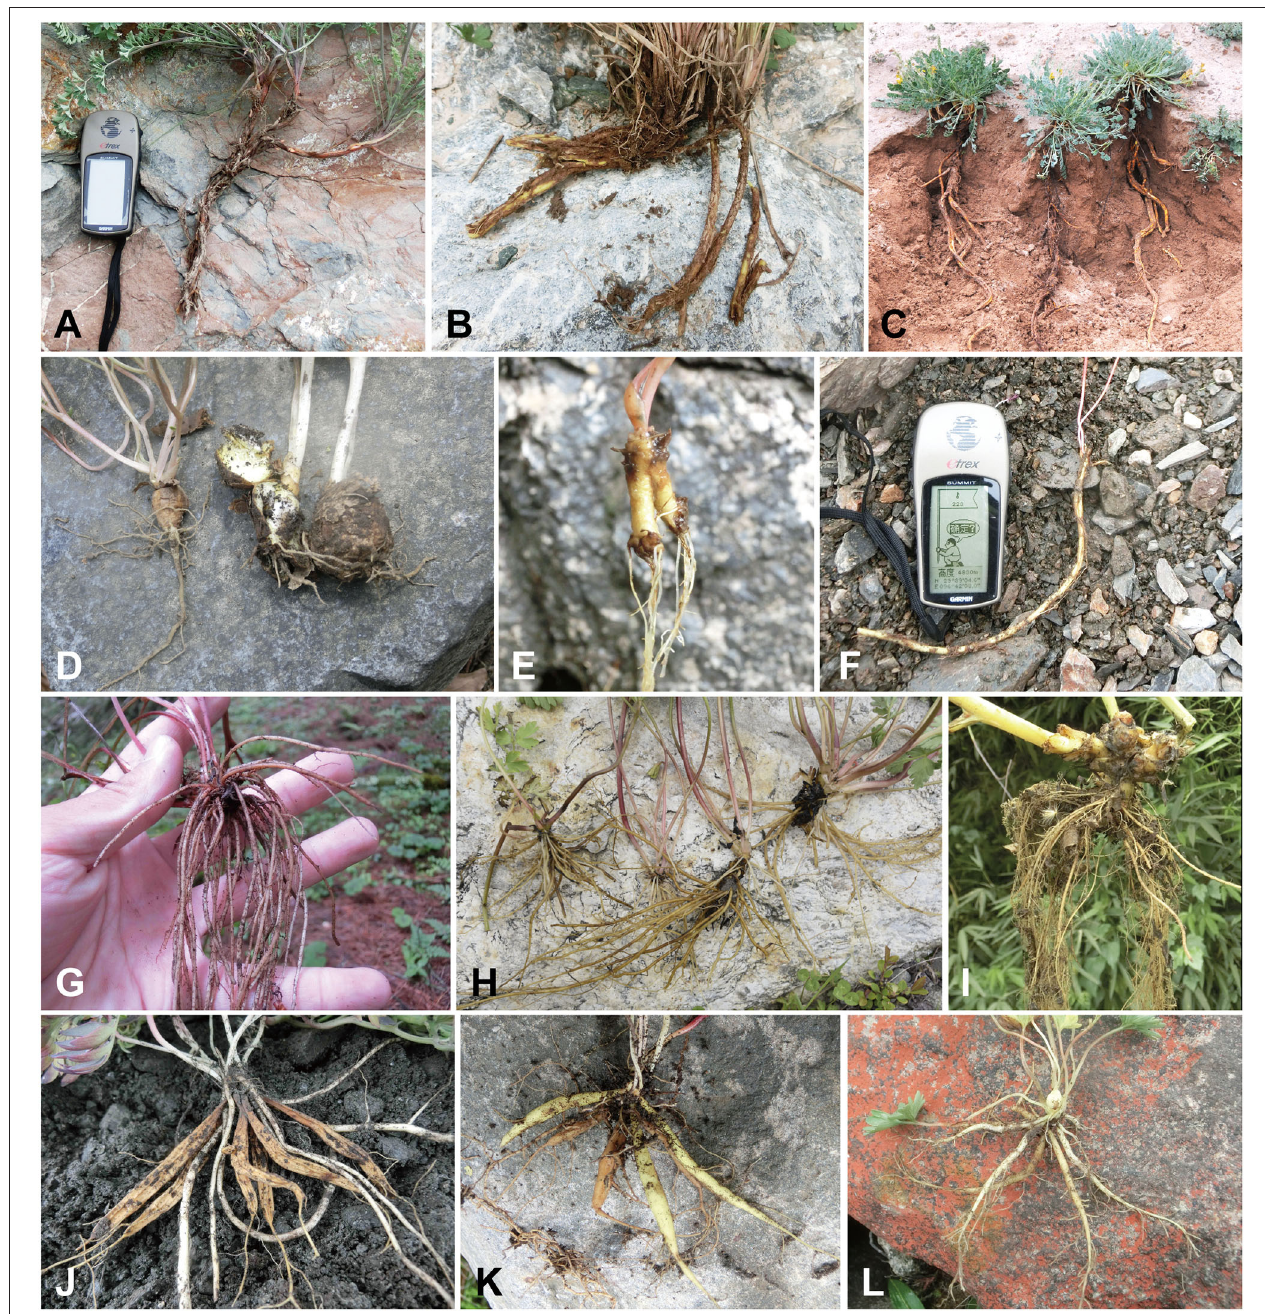
FIGURE 5 | Morphology of root and rhizome of Corydalis species. With taproot: (A) C. stricta , clade I; (B) C. livida , clade IV; (C) C. wuzhengyiana , clade V. With tuber; (D) C. caudata , clade IV; (E) C. hsiaowutaishanensis , clade IV. With long thin rootstock; (F) C. retingensis , clade IV. With fibrous root; (G) Corydalis sp. (sect. Davidianae ), clade V; (H) C. elata , clade VI; (I) C. mucronate , clade VI. With enlarged storage root; (J) C. trachycarpa , clade V; (K) C. minutiflora , clade VI; (L) C. pseudoadoxa , clade VI.